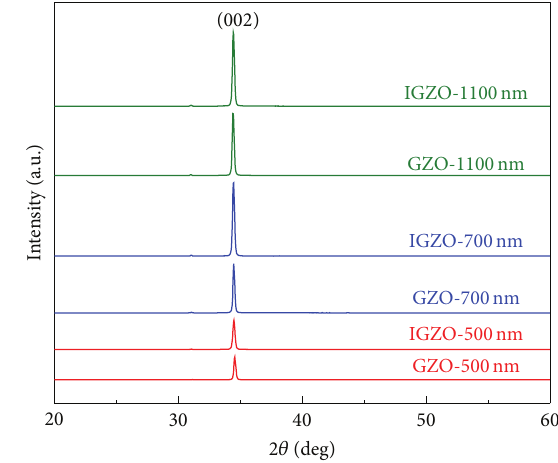
Figure 6: X-ray diffraction patterns of postannealed GZO (A sample) and IGZO (B sample) films with various film thicknesses for